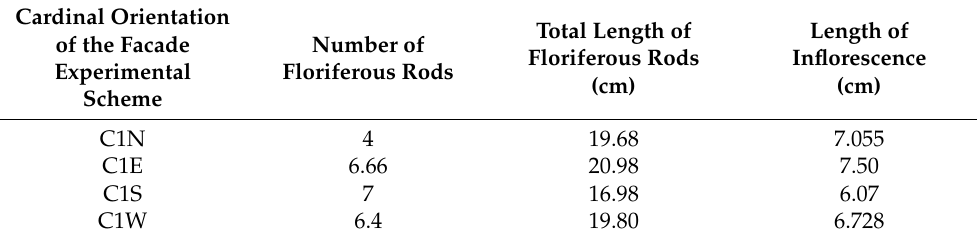
Figure 18. Evolution of the number of leaves in Heuchera x hybrida ‘Fire Alarm’, May–December 2020. The southern orientation favored flowering, which started in May on the mentioned orientation, followed by the eastern and western orientations and then on the northern facade. On the southern and western facades, the duration of flowering was the longest, respectively, until mid-November. The number of floriferous stems was higher on the southern facade, but the lengths of the floriferous stems as well as the inflorescences had the lowest average values. The highest average values for these parameters were recorded on the eastern facade closely followed by those obtained on the western facade (Table 2). Table 2. Flowering Heuchera x hybrida ‘Fire Alarm’ 2020.